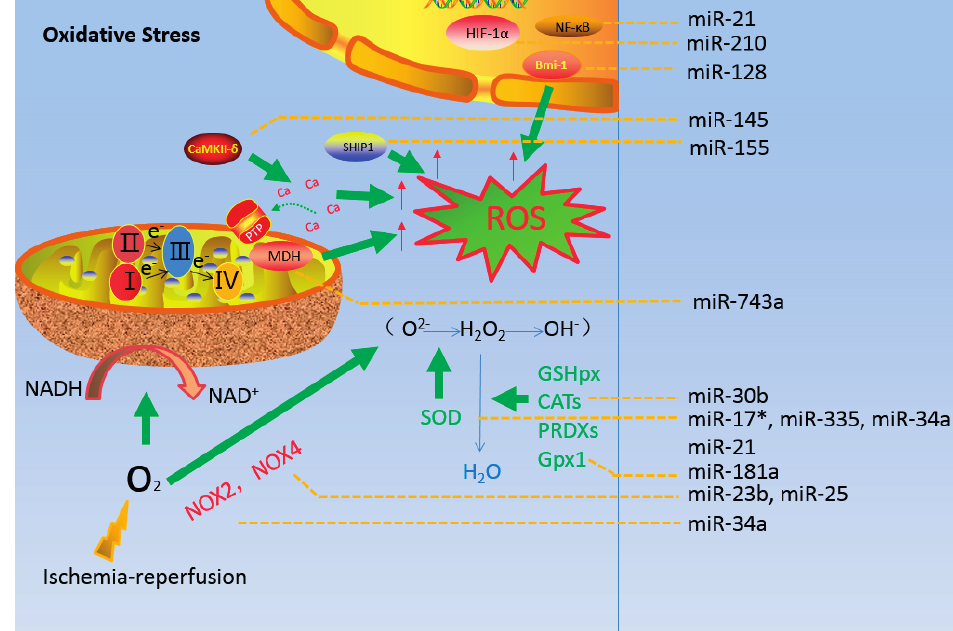
Figure 1. Regulatory role of miRNAs in mitochondrial oxidative stress during brain ischemia-reperfusion